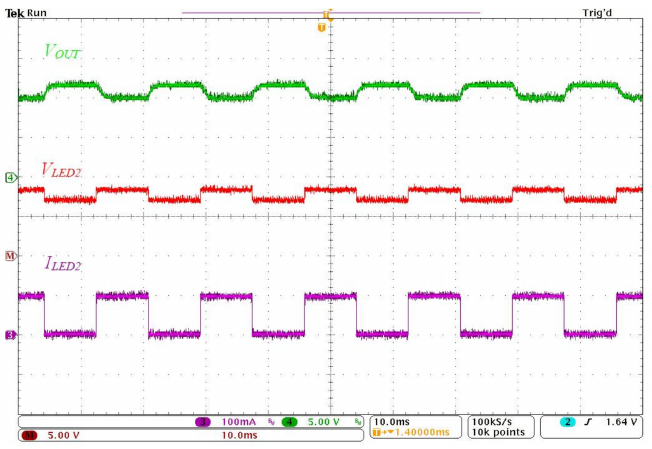
Figure 15. Measured waveform of LED string2.